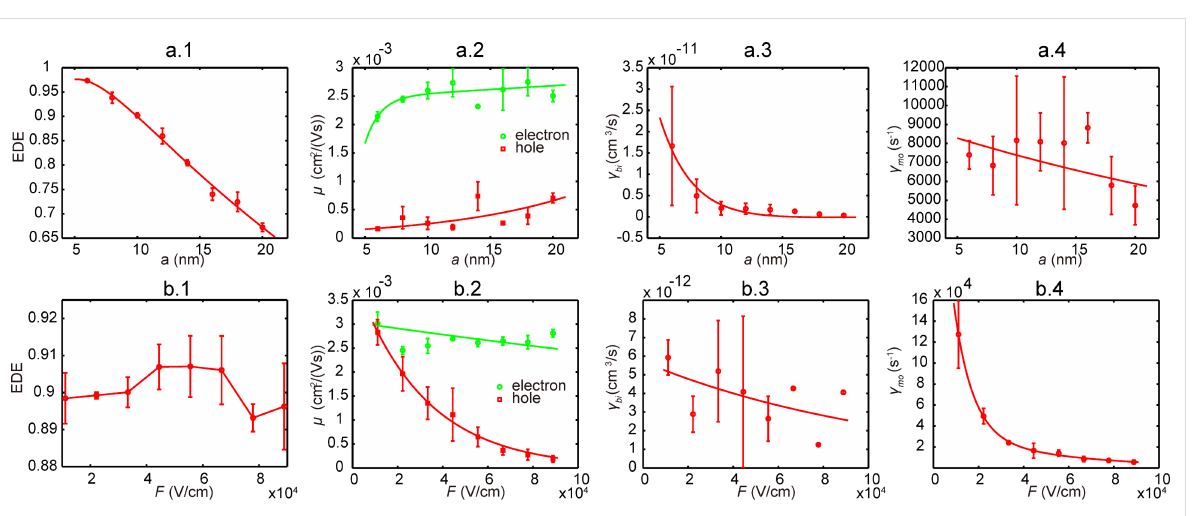
Figure 6: MC simulation results for PCPDTBT/PCBM (1:2) active layer. (a.1–4) presents the EDE, carrier mobility, bimolecular and monomolecular recombination rate with respect to domain size. (b.1–4) presents the results with respect to electric field.